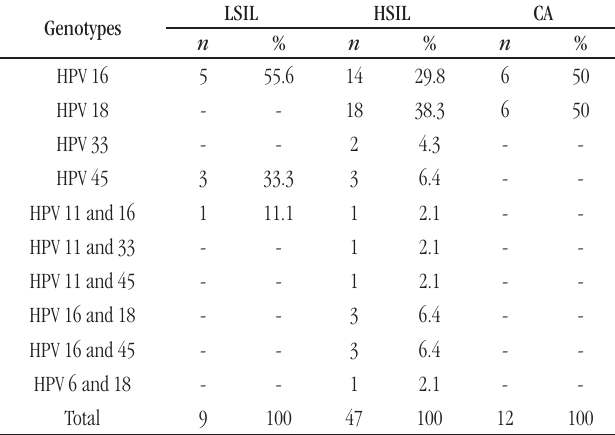
taBLE 2 − Distribution of HPV genotypes according to the histopathological findings in samples of cervical biopsies ( n = 68)